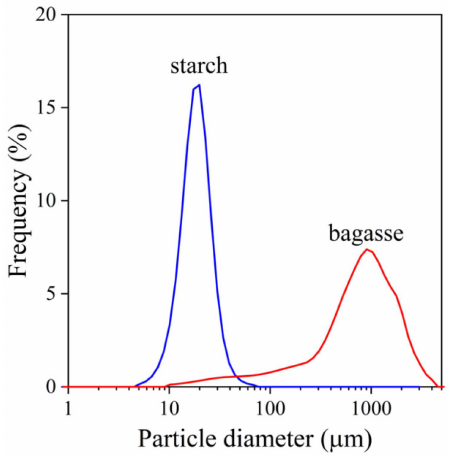
Figure 1. Particle size distribution of the additives as determined by laser light scattering.